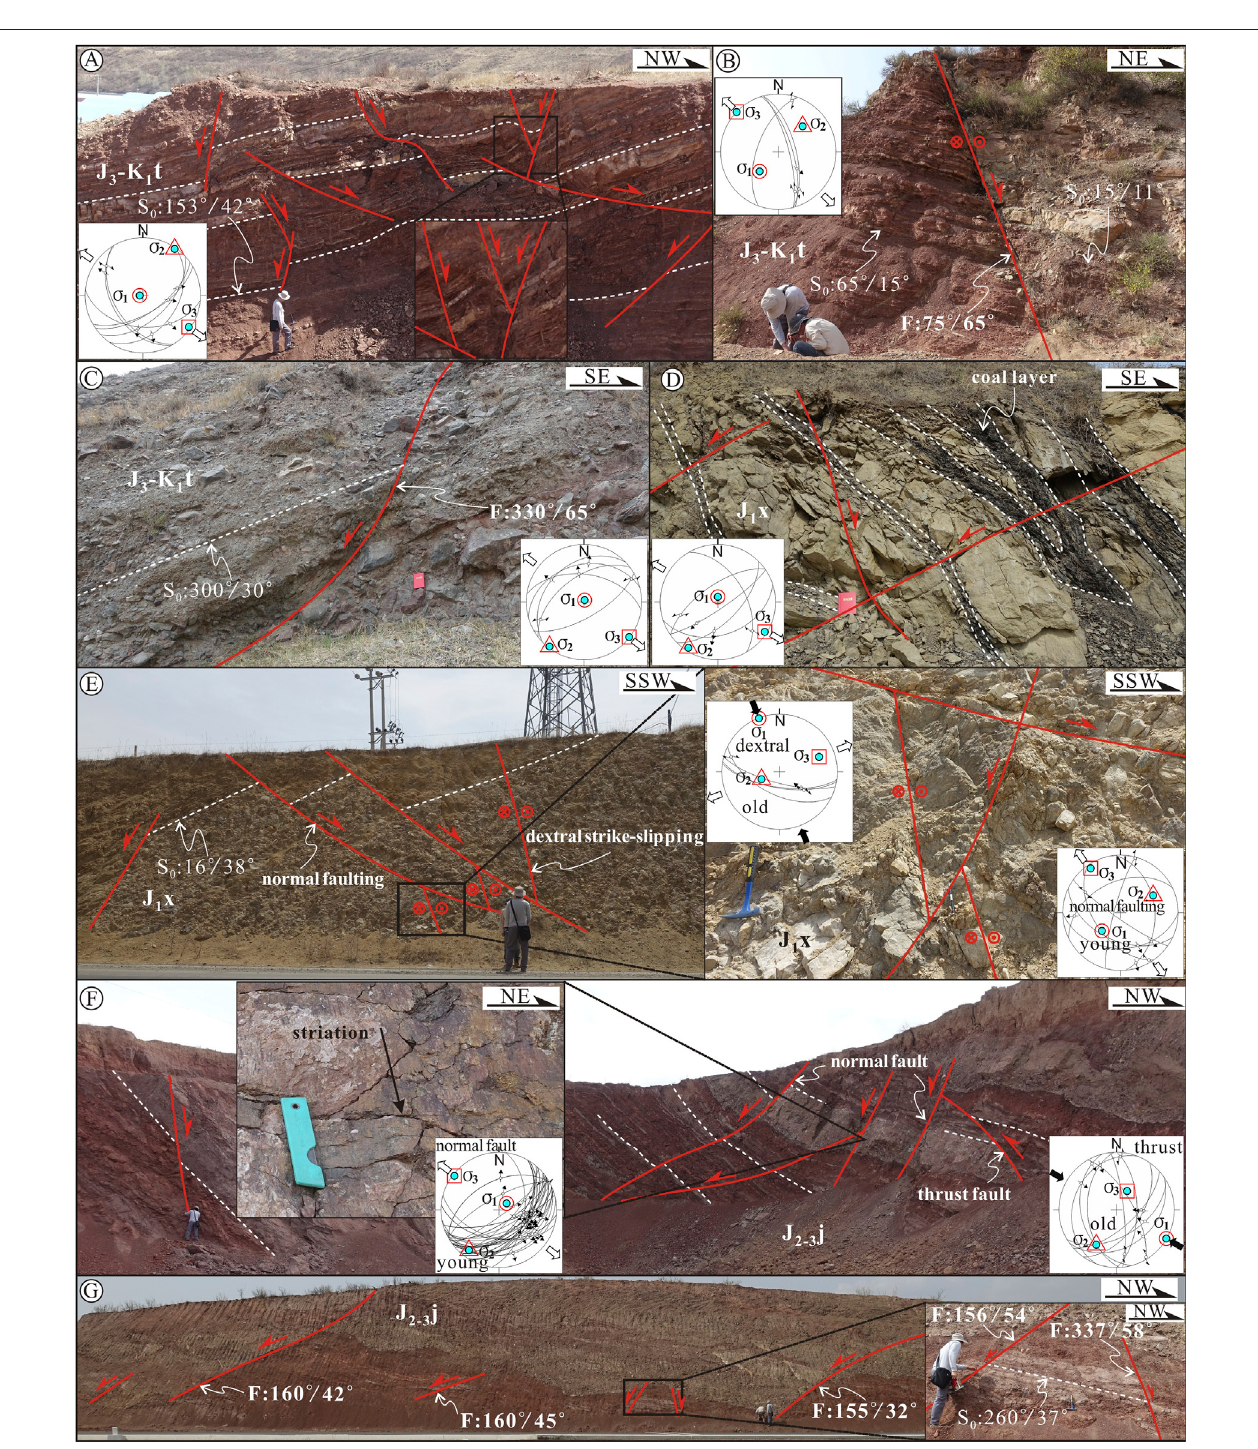
FIGURE7 | Representative outcrop photographs related toregionalNW-SE extension. Photo (A – C) shows that some small-scale normal and strike-slip faults are developed in the Tuchengzi Formation and re fl ect NW-SE extensional deformation. (D) At the south of Xiajing, the later SE- or NW-dipping normal faults dislocate the early tight folds in the coal-bearing sandstones in the Xiahuayuan Formation. (E) Two groups of faults crop out in the Xiahuayuan Formation sandy conglomerates at the southwest of Shangyi. And the dextral strike-slip faults are cut by the SSW-dipping transtensional faults, corresponding to NW-SE compression and NW-SE extension, respectively. (F) Two-phase faults are exposed in the Jiulongshan Formation at the northeast of Hongtuliang, and the early NW-dipping reverse faults are truncated by the lather SE-dipping normal faults, corresponding to NW-SE compression and NW-SE extension, respectively. (G) Some NW- and SE-dipping extension faults and well-developed horst are marked in the Jiulongshan Formation at the northeast of Hongtuliang. Lower hemisphere, equal-area projections.